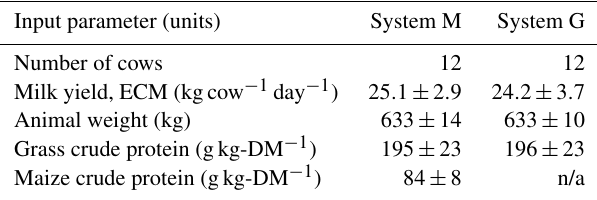
Table 2. Measured averages ± standard deviation of observed cow properties (ECM: energy corrected milk) and feed protein contents used by the dairy cow nitrogen budget approach for both pasture systems during the grazing season